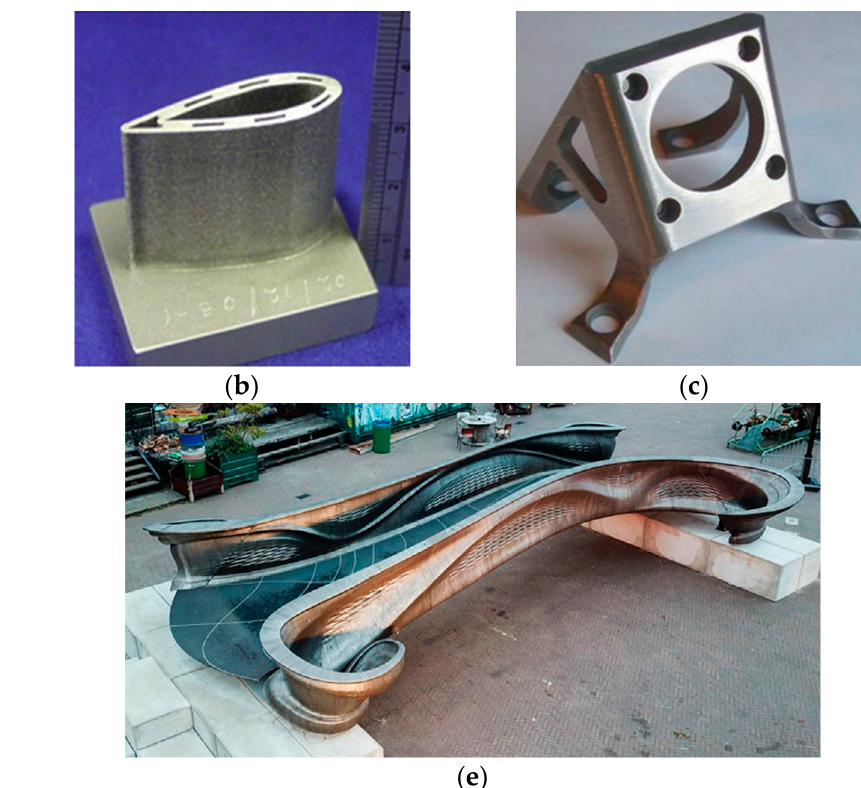
Figure 2. Metal AM parts. ( a ) DMLM-ed stainless steel gas turbine housing. Reprinted with permission from Ref. [18], Elsevier, 2017. ( b ) DMLM-ed Ti6Al4V airfoil [18], ( c ) CSAM-ed Ti bracket. Reprinted with permission from Ref. [2], Elsevier, 2018. ( d ) CSAM-ed and DMLM-ed bimetallic thrust chamber. Reprinted with permission from Ref. [73], NASA, 2021. ( e ) WAAM-ed stainless steel bridge in Amsterdam. Reprinted with permission from Ref. [74], Elsevier, 2019. Unit: mm.